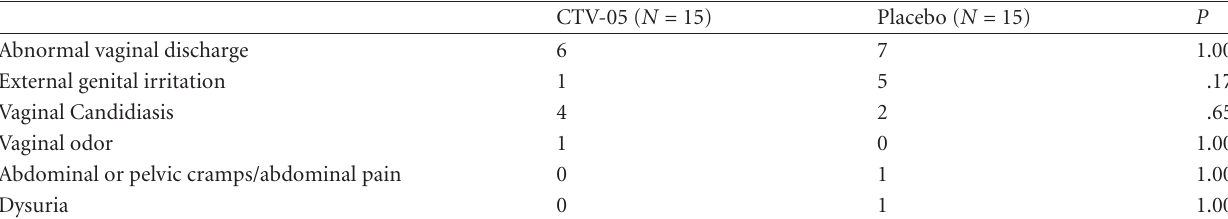
Table 2: Adverse events related to study drug use.